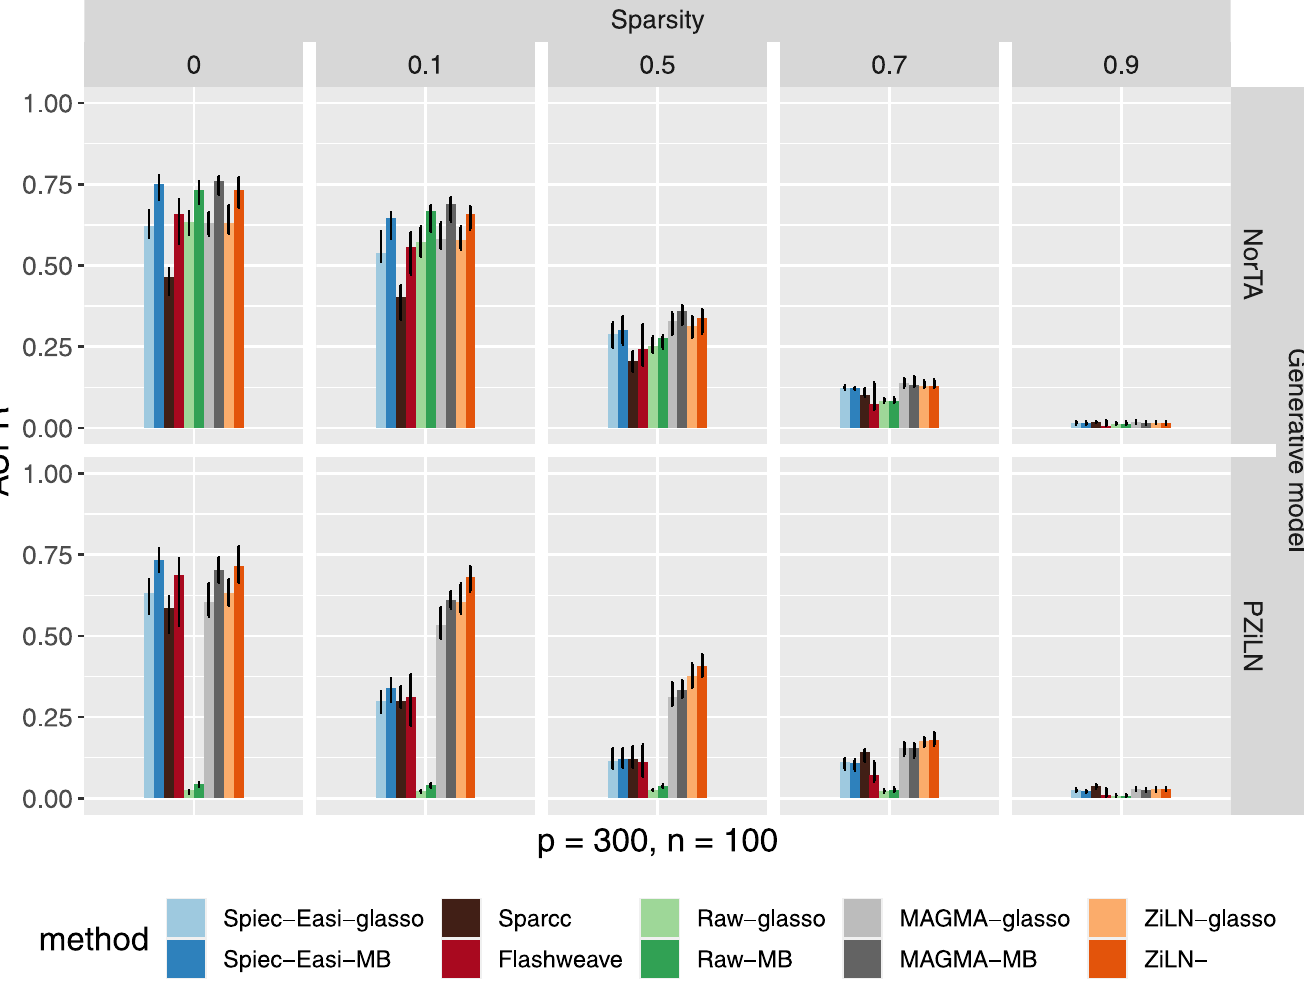
Fig 3. Effect of the amount of zeros in the data (vertical panels) on method performance. Top panel: network reconstruction accuracy for various methods using synthetic data generated with the NorTA protocol using zero inflated negative binomial marginals (see Methods). Bottom panel: network reconstruction accuracy using data generated under the zero inflated log-normal (ZiLN) model. Notations are as in Fig 2, and results are shown for the Erdos-Renyi topology.